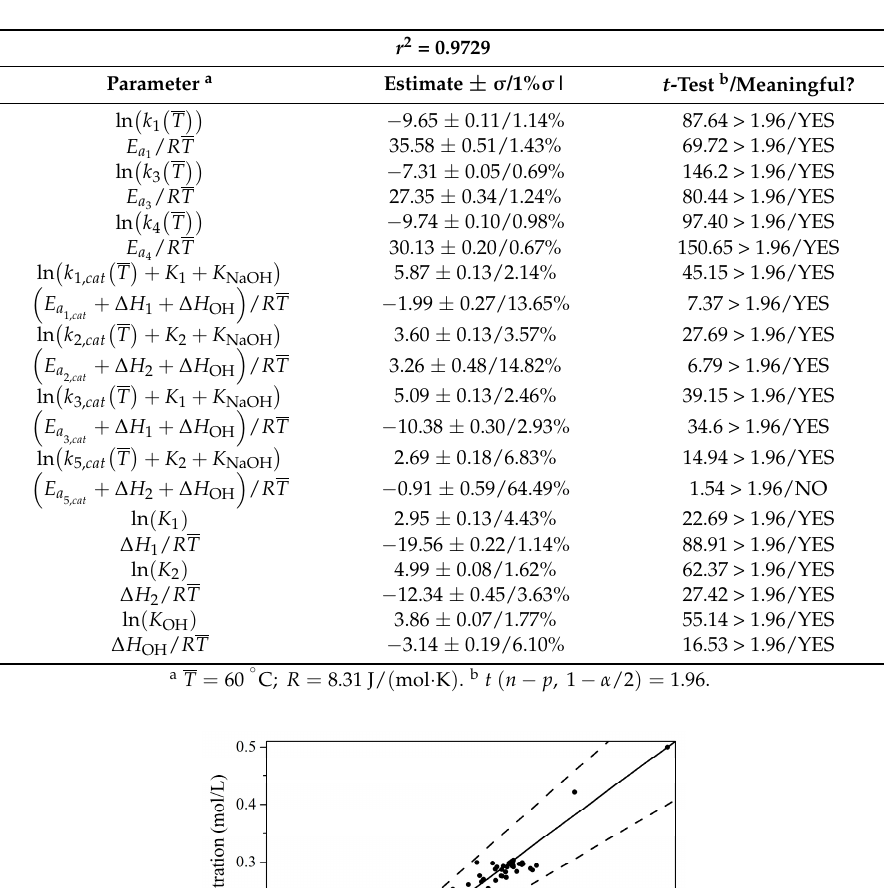
Table 2. Regression coefficient of the kinetic model and estimates of the kinetic parameters using all experimental data.